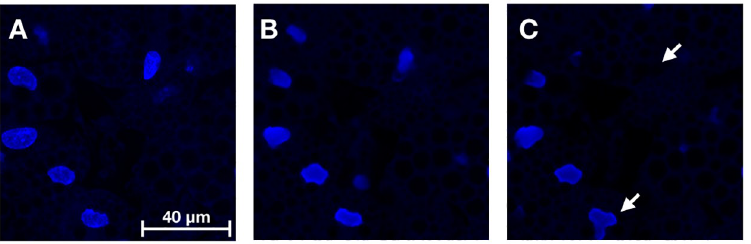
Fig 6. A comparison between the LWM based model (applying LUPI) and the base model for virtual staining of the nuclear channel. (A) Ground truth fluorescence image, (B) Output from LWM model (C) Output from the base model. The arrows in (C) point out a missing nucleus and an incorrectly shaped nucleus for the base model’s prediction. Images are displayed with the same dynamic range for visualization purpose.